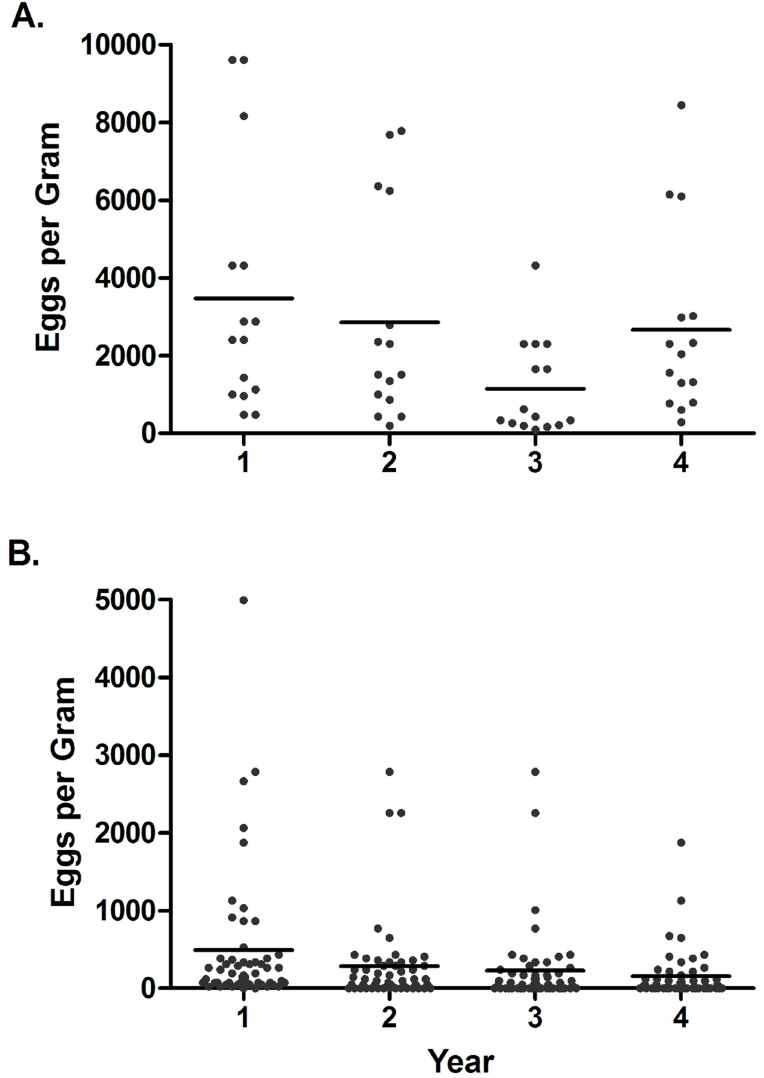
Figure 1. Mean number of schistosome eggs per gram of feces in patients for four years during annual mass praziquantel administration to school aged children. A. 15 patients deemed ‘‘phenotypically susceptible’’ to schistosomiasis during MDA from which genetic samples were collected. Differences were due to a decrease in prevalence rather than a reduction in egg counts in infected individuals B. 52 randomly sampled children. Note the difference in scale of the Y-axis of both figures as egg burdens were much higher in the phenotypically susceptible group.